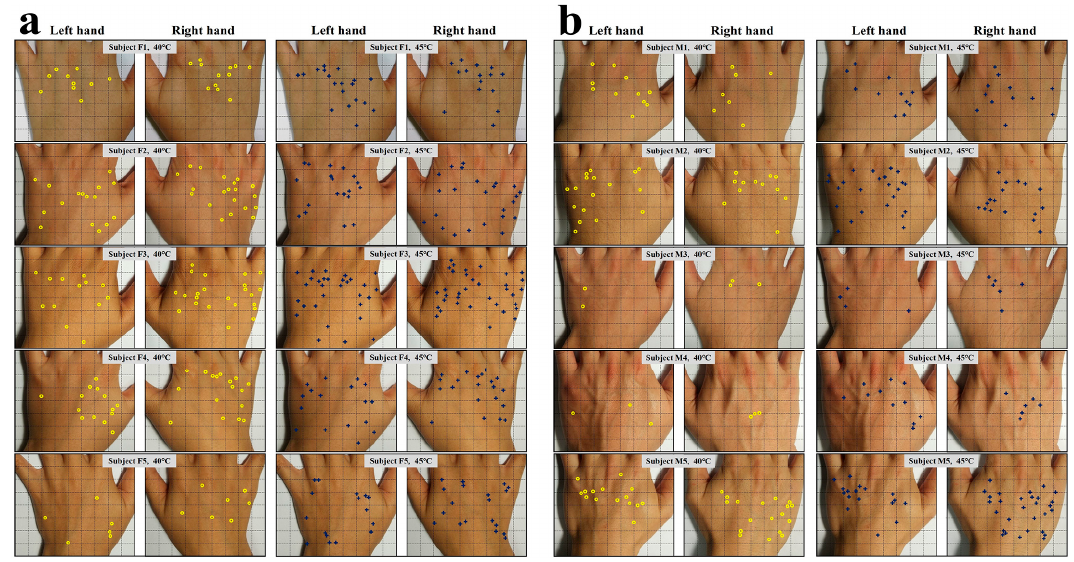
Figure 4. Photographs for the locations of sensory spots on the back of hands of 10 subjects. The locations of sensory spots of ( a ) the five female subjects and ( b ) the five male subjects responded to at 40.0 °C and 45.0 °C are highlighted by yellow circles and blue crosses, respectively.